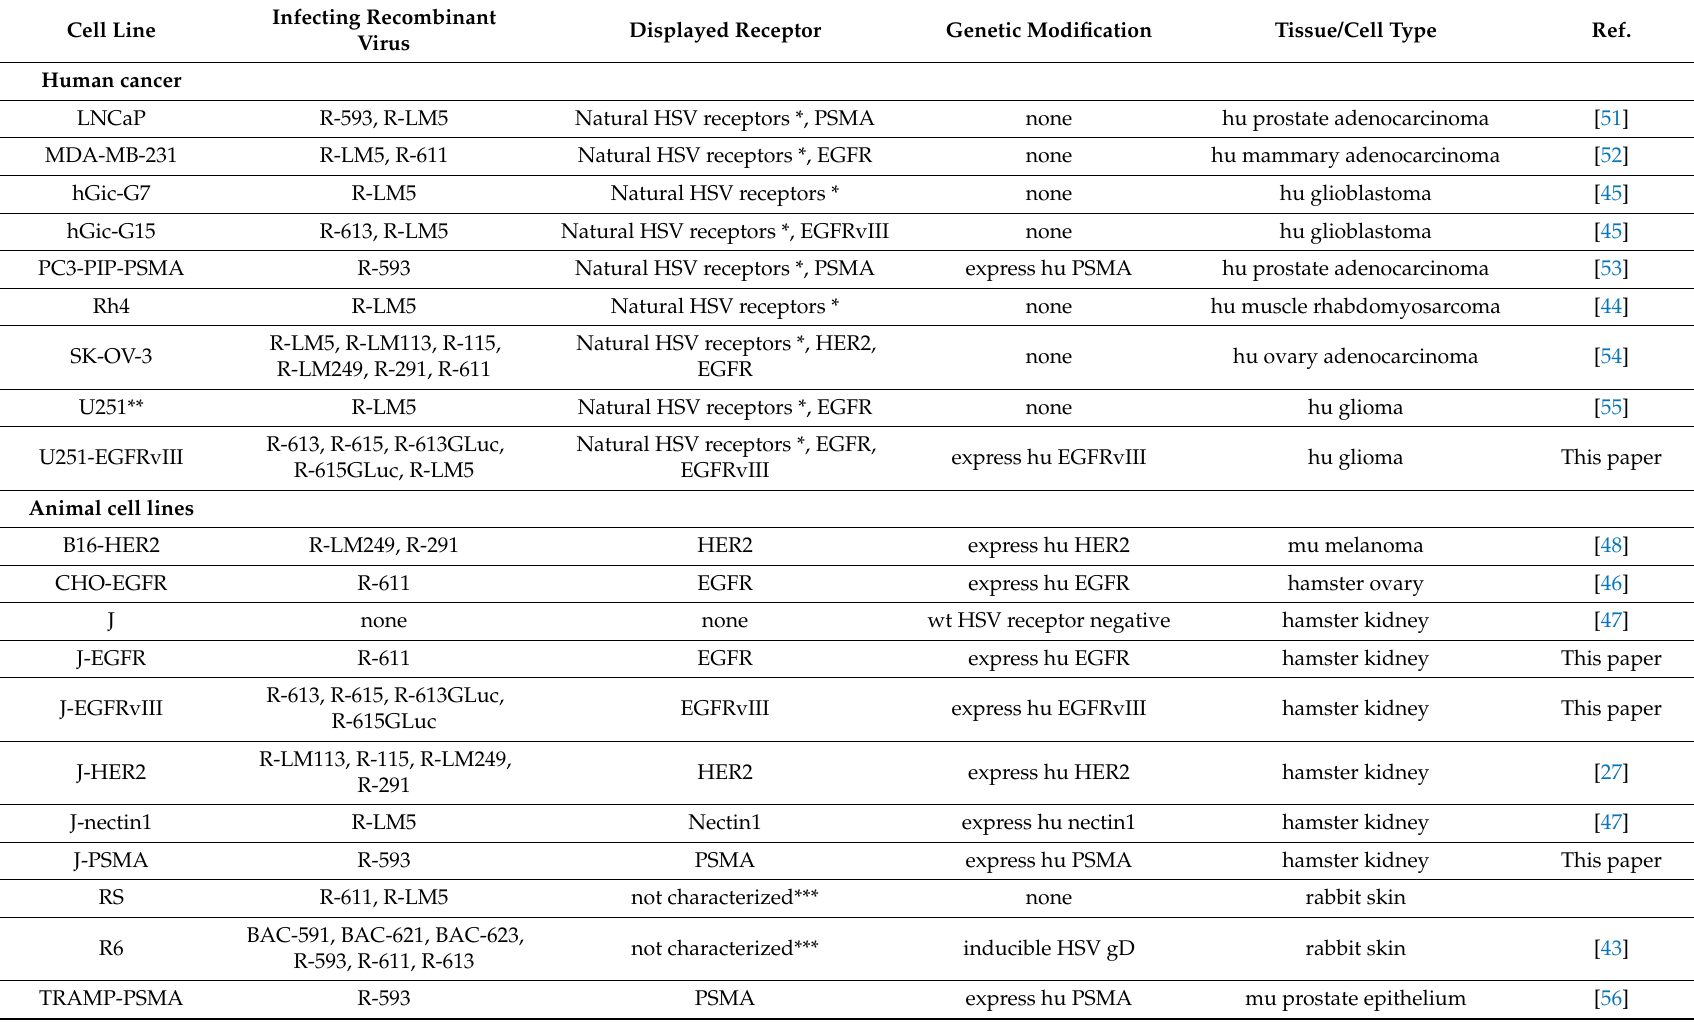
Table 2. Cell lines employed for the characterization of the recombinant viruses and